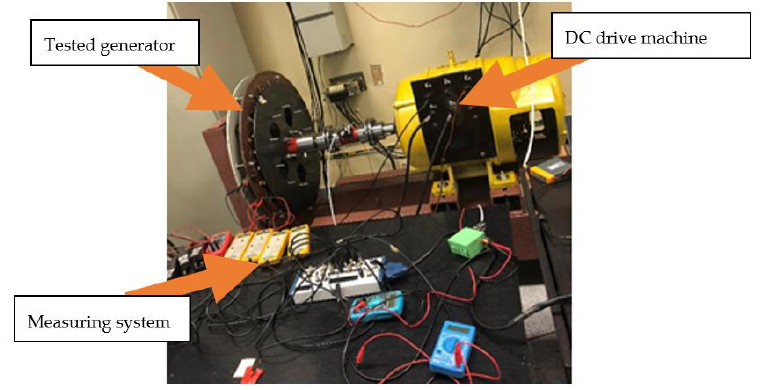
Energies 2020 , 13 , x FOR PEER REVIEW